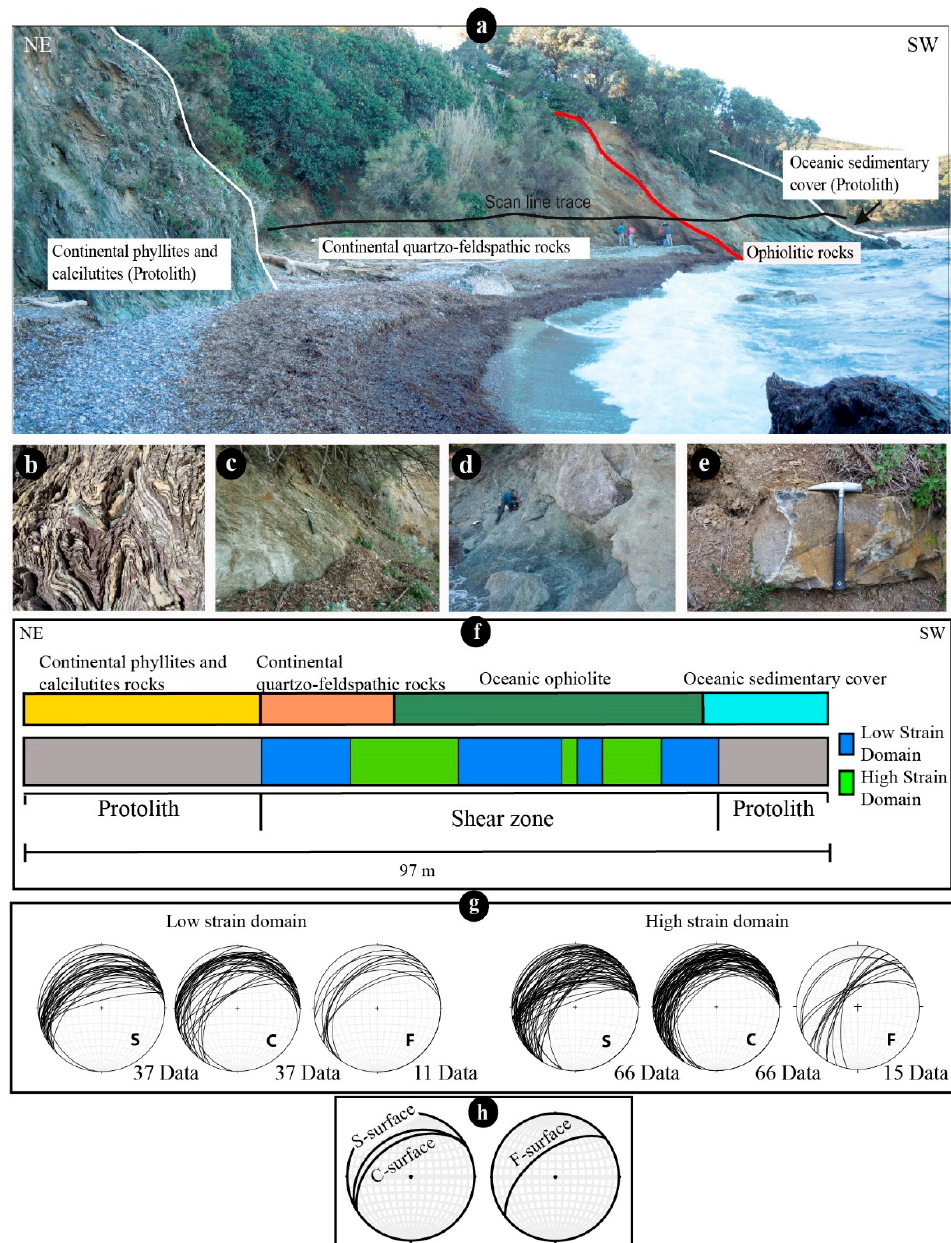
Figure 3. Capo Castello analyzed shear zone involving the quartzo-feldspathic rocks belonging to the Continental Unit 3 and the ophiolite-bearing rocks, with their sedimentary cover, belonging the Oceanic Unit 2. ( a ) Panoramic view of the study area with the boundary between di ff erent rock formations involved in the faulting and the scan line trace in black; ( b ) Protolith (i.e., the rock undeformed by the study shear zone) of calcschist and phyllite characterized by isoclinal folds; ( c ) metasandstones involved in the shear zone; ( d ) serpentinite level in the shear zone; ( e ) protolith with limestone and shale, structurally located over the serpentinite; ( f ) scan-line showing the lithology, and the distribution of the strain domains; ( g ) Structural data (lower hemisphere, Schmidt diagram) of the low and high strain domains. Stereoplots indicate cyclographic traces of C and S surfaces and of the brittle west-dipping structures F see the text for description; ( h ) Average stereoplots showing top-to-the ESE shear sense (to the right) and west dipping brittle structures (to the left).Structural and kinematic data are plotted in stereographic diagrams, lower hemisphere, equiareal projection. Stereograms were obtained by OSX Stereonet, from: http: // www.geo.cornell.edu / geology / faculty / RWA /